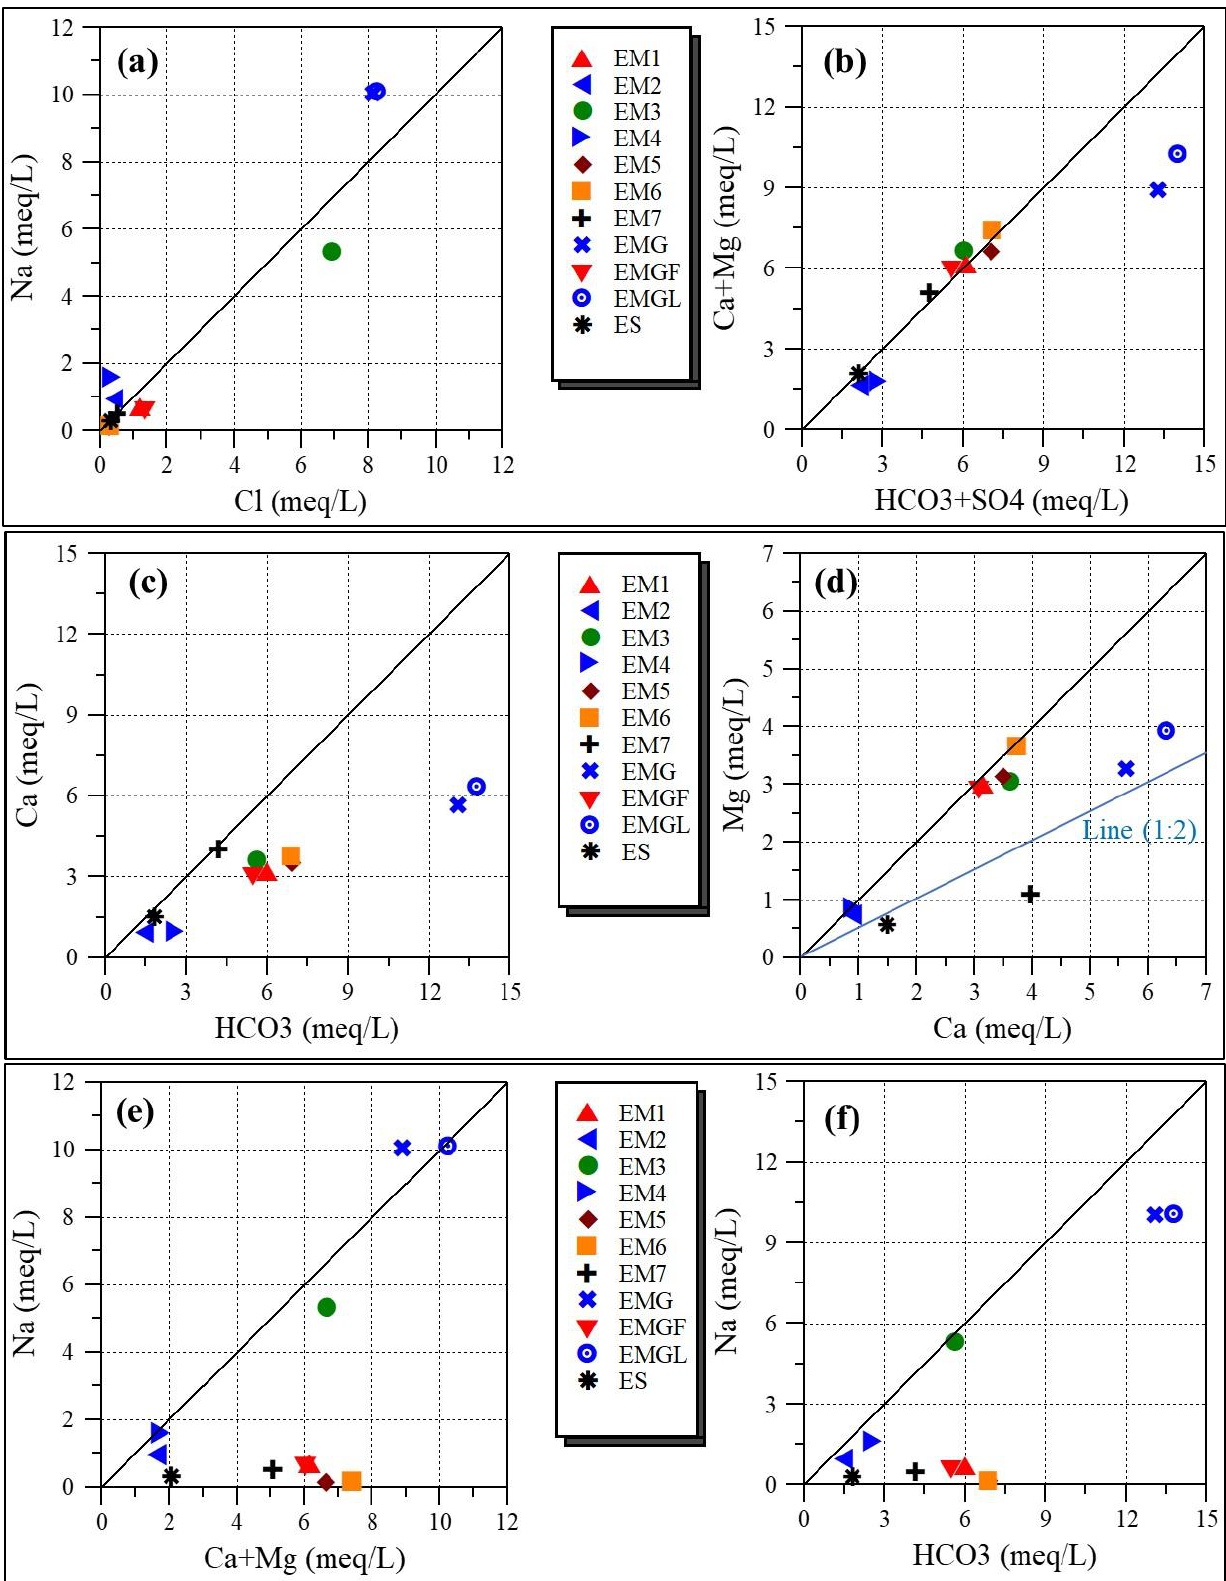
Figure 4. Binary correlation plots between different parameters. ( a ) Na vs. Cl; ( b ) (Ca + Mg) vs. (HCO 3 + SO 4 ); ( c ) Ca vs. HCO 3 ; ( d ) Mg vs. Ca; ( e ) Na vs. (Ca + Mg); ( f ) Na vs. The variations of geochemical mechanisms in the aquifer system can also be inter- preted from different scatter plots. This allows hypotheses to be made on the origin of